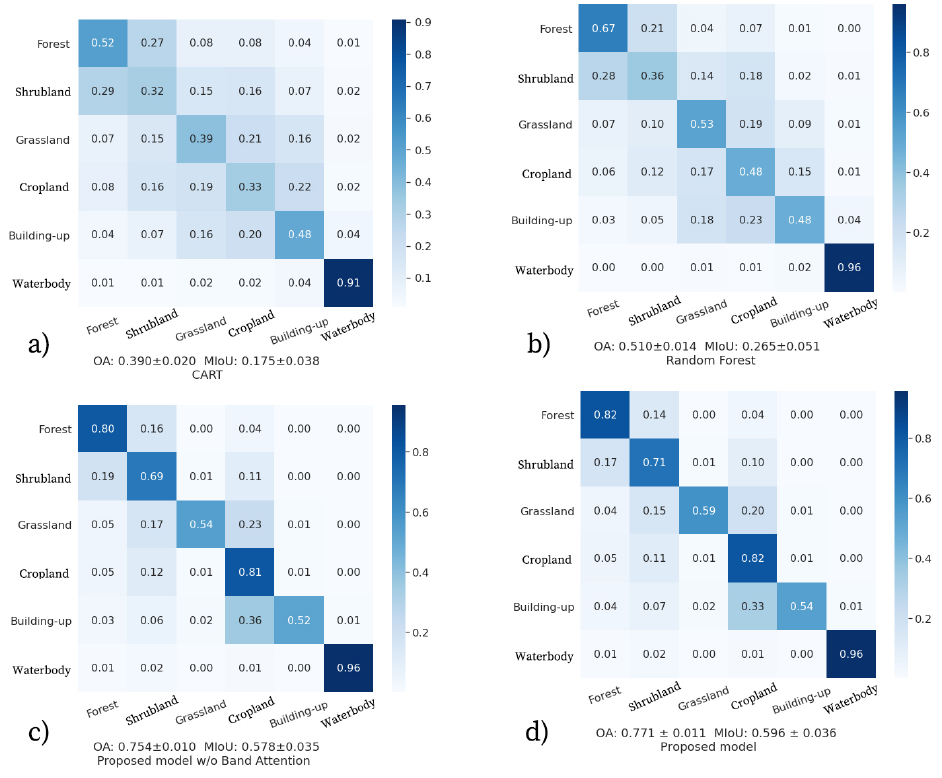
Figure 8. Confusion matrix of the classification results achieved by CART, RF, and our proposed model without and with BA.